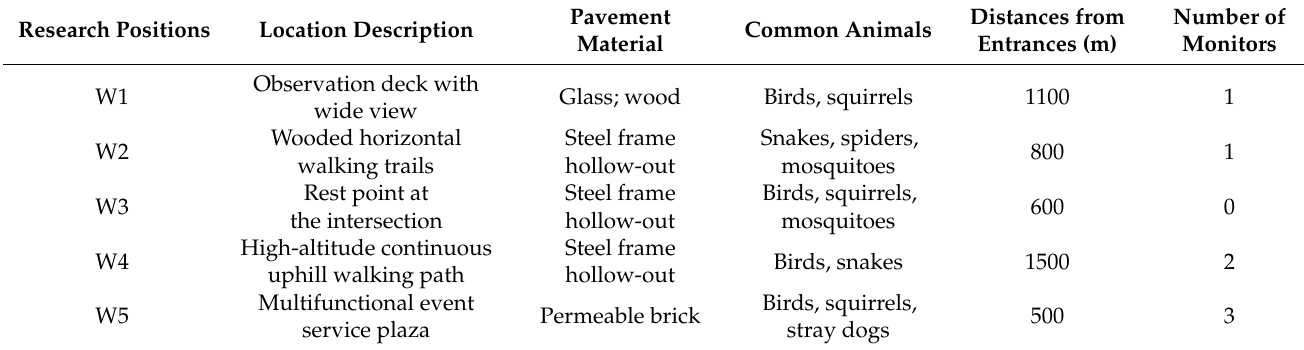
Table 1. Study site descriptions of Fuzhou Urban Forest